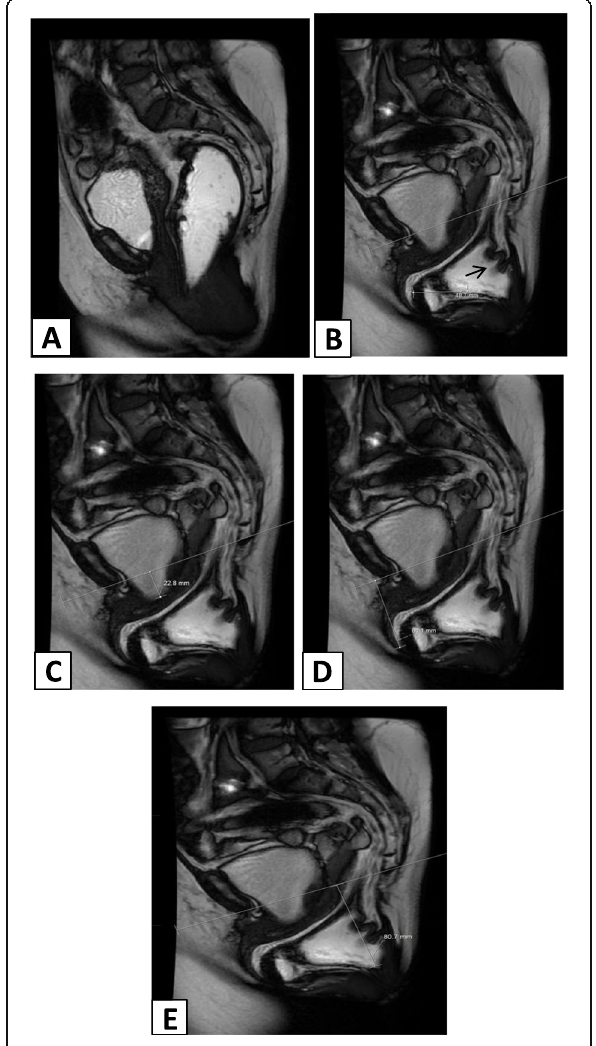
Fig. 3 Mid-sagittal SSFP obtained ( a ) at rest and ( b – e ) during defecation showing large anterior rectocele (4.8 cm), mild cystocele (2.2 cm), severe both enterocele (6 cm), and rectal descent (8 cm) with evidence of full-thickness intussusception [arrow]